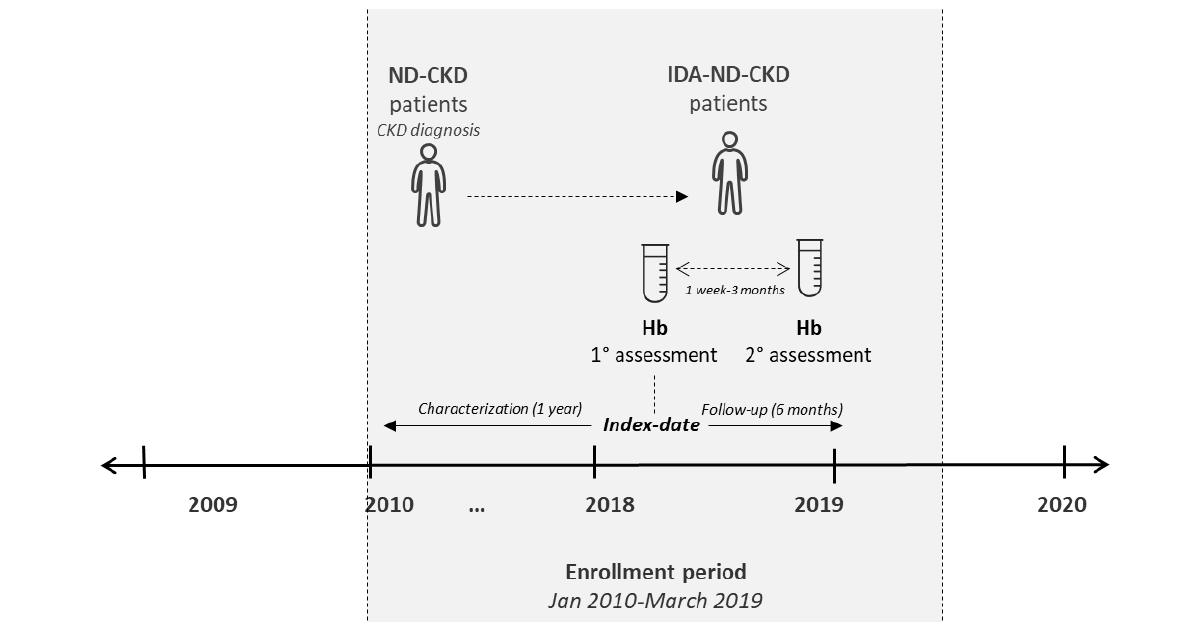
Figure 1. Schematic representation of the study design. Non-dialysis (ND) patients with a diagnosis of chronic kidney disease (CKD) (ND-CKD) were identified during the enrolment period; those presenting two low Hb measurements (with an interval between 1 week and 3 months) were defined as iron-deficiency anaemia (IDA)-ND-CKD.